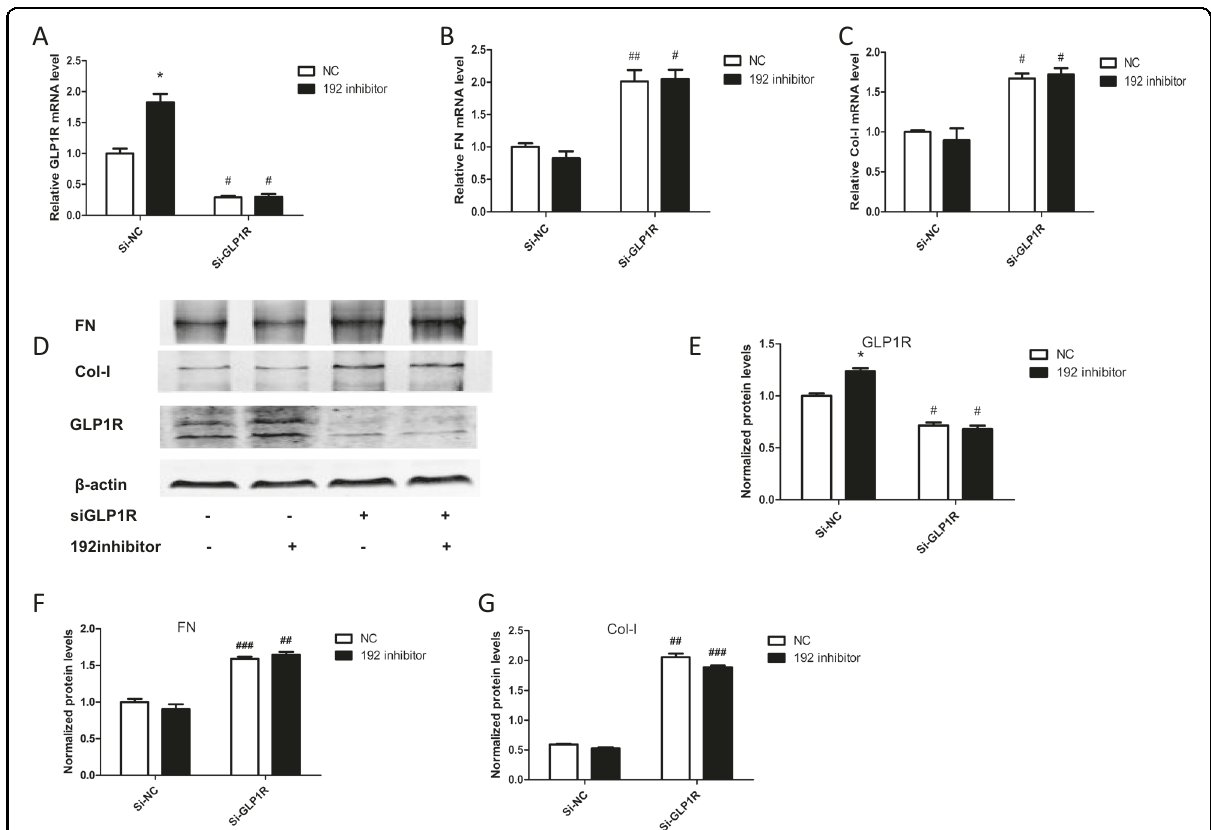
Fig. 8 MiR-192 regulated renal fi brosis through GLP1R. a – c Relative expression of GLP1R, FN, and Col-I in HK-2 cells co-transfected with both si- GLP1R and the miR-192 inhibitor. d – g GLP1R, FN, and Col-I expression in HK-2 cells co-transfected with both si-GLP1R and the miR-192 inhibitor was analyzed by western blot (* P < 0.05 and ** P < 0.01 versus the NC group; # P < 0.05, ## P < 0.01, and ### P < 0.001 versus the Si-NC group)